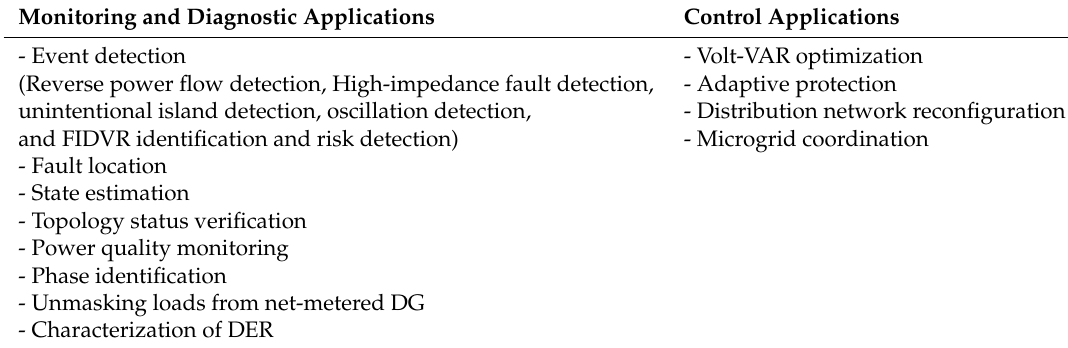
Table 2. Applications of µ PMU data in distribution